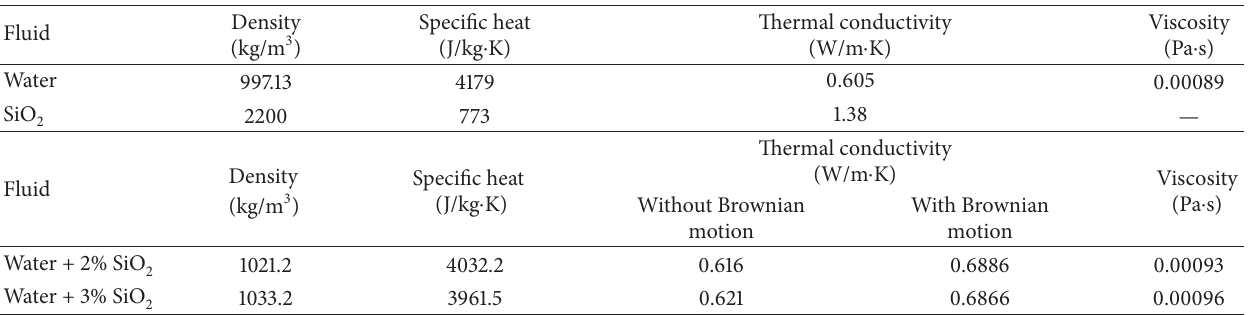
nanofluids of different concentrations. 2